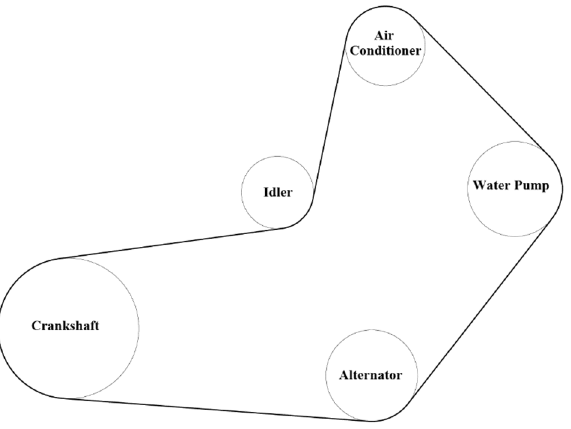
Figure 1. Car engine and FEAD system 3